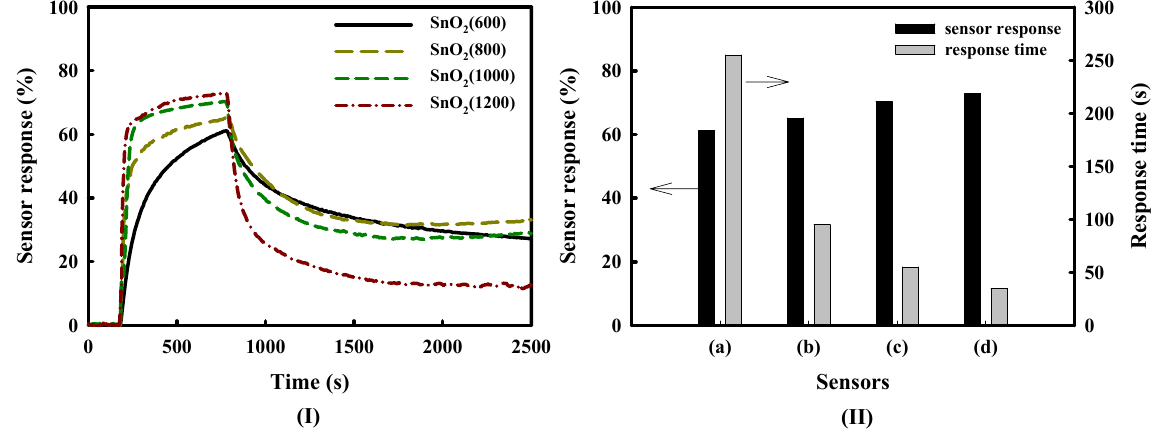
Figure 2. ( I ) Response curves, ( II ) responses, and (II) 80% response times of SnO gas sensors, such as (a) SnO a H S concentration of 1.0 ppm at 350 2